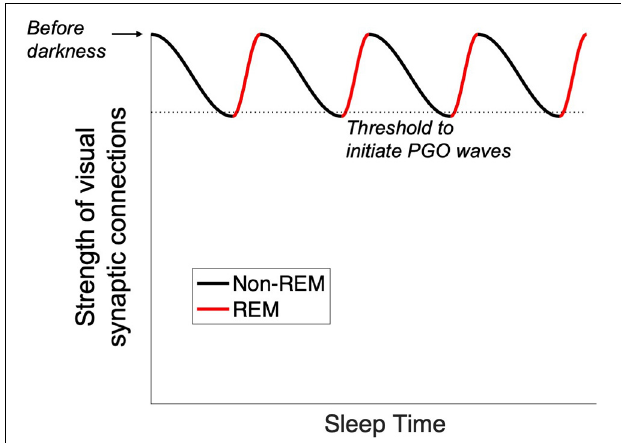
FIGURE 5 | Proposed trigger for the onset of PGO waves. With the onset of sleep, visual synaptic connections are weakened by encroachment from other sensory areas. When a threshold is reached (dotted line), PGO waves are initiated and drive activity into the occipital lobe. This process repeats cyclically throughout the sleep cycle.